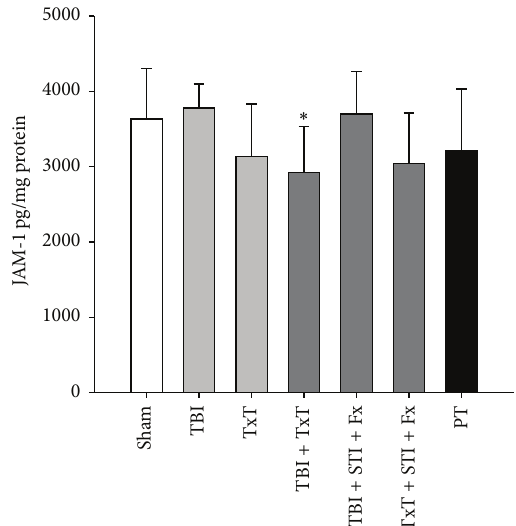
Figure 2: JAM-1 concentration of murine lung tissue homogenates per mg protein 2 h after experimental blunt chest trauma (TxT), closed traumatic brain injury (TBI), femur fracture including contralateral soft tissue injury (STI + Fx), and a combination of injuries (PT). Results are presented as means ± SD with 𝑛 = 7-8 per group; one-way ANOVA/Dunnett’s test; ∗ 𝑃 ≤ 0.05 versus sham.